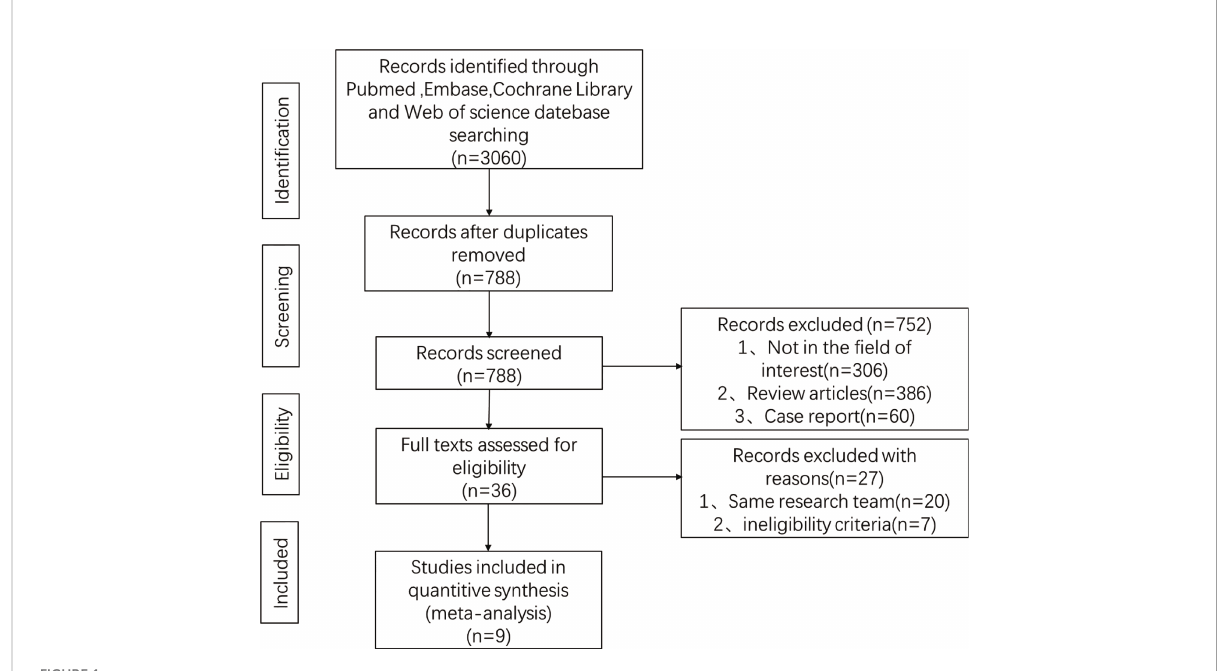
FIGURE 1 Flow diagram of the study selection